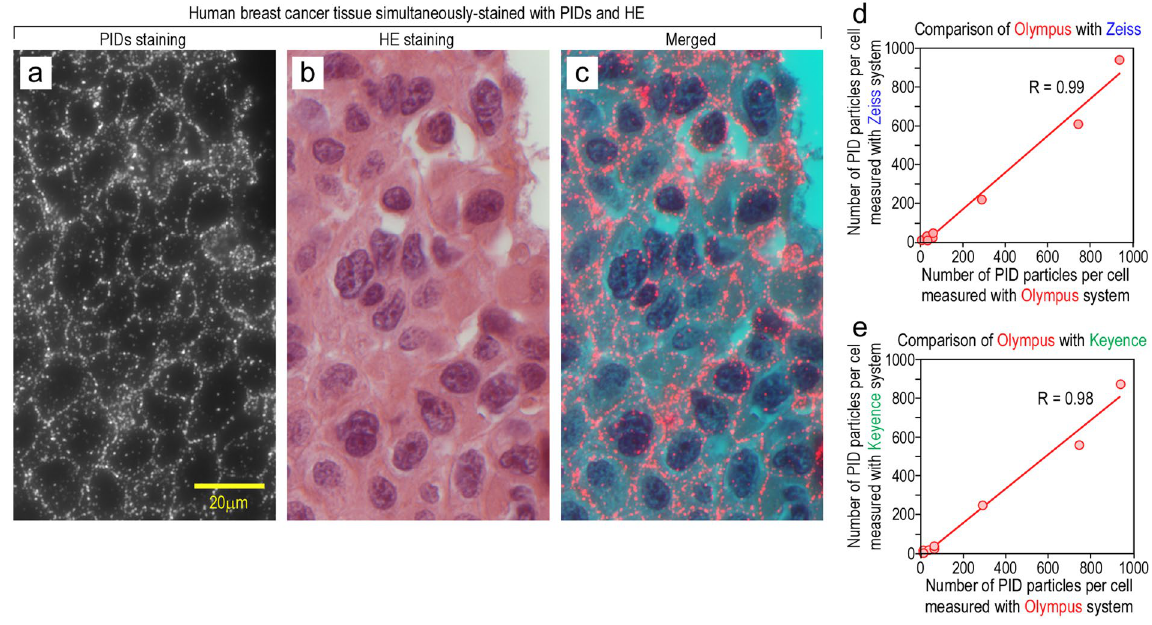
Figure 6. Examination of versatility of IHC-PIDs. ( a – c ) Double staining of cancer tissue with PID and HE. The samples were immunostained with PIDs ( a ) and then stained with HE ( b ). In previous studies, double staining using fluorescence and eosin has been challenging because the fluorescence intensity of eosin is relatively high. However, the fluorescence intensity of the PIDs was higher than that of eosin. Thus, PID staining enabled us to simultaneously observe both the cellular morphology and the cellular properties using a single tissue section ( c ). Bar, 20 μ m. ( d , e ) To provide more evidence of the versatility of IHC-PIDs, we evaluated the correlation between data obtained using fluorescence microscopes from the Olympus, Zeiss, and Keyence corporations. HER2 expression in cultured cells of eight types of breast cancer, shown in Fig. 4g, was quantified by the number of PID particles per cell using Zeiss and Keyence fluorescence microscopes. We then evaluated the correlation between the data obtained using fluorescence microscopes from Olympus and Zeiss ( d ) and Olympus and Keyence ( e ). The data obtained using the Zeiss and Keyence microscopes were significantly correlated with the Olympus data (both with correlation coefficients R >